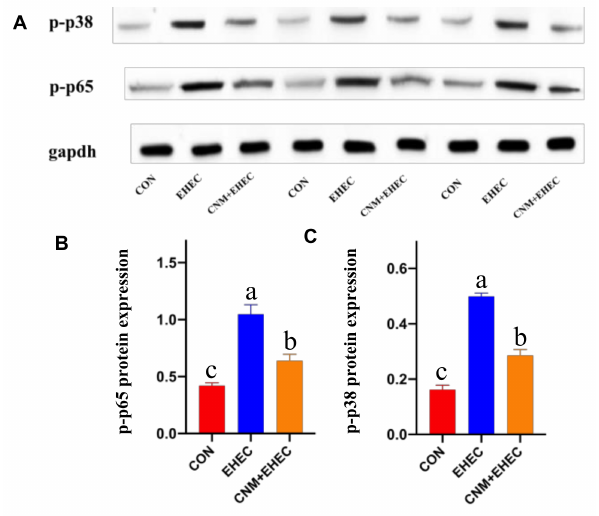
Figure 8. Phosphorylated NF- κ B and p38 MAPK pathways were analyzed by Western blotting. Cells were collected after E. coli O157 challenge. ( A ) Presentive image of the bands of phosphorylated p38 and phosphorylated NF-Kb. ( B ) Relative protein abundance of p -NF- κ B and ( C ) p -p38. The results are presented as means ± SEM. n = 3. Means with different lowercase letters differ significantly by Tukey’s test ( p <